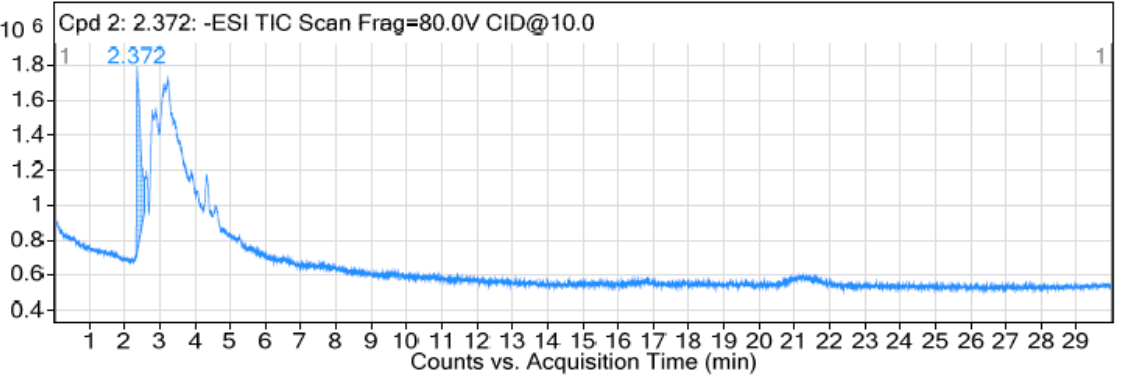
Figure 3. LC-MS chromatogram of the hydrolysate.